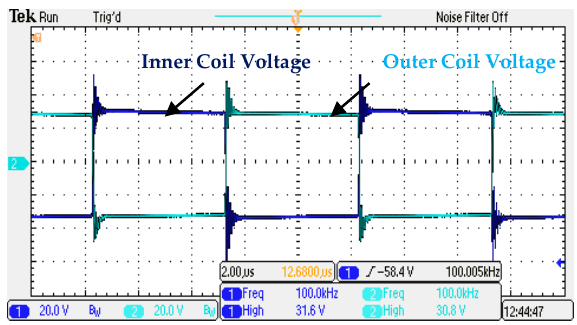
Figure 14. Structures of the power coils.